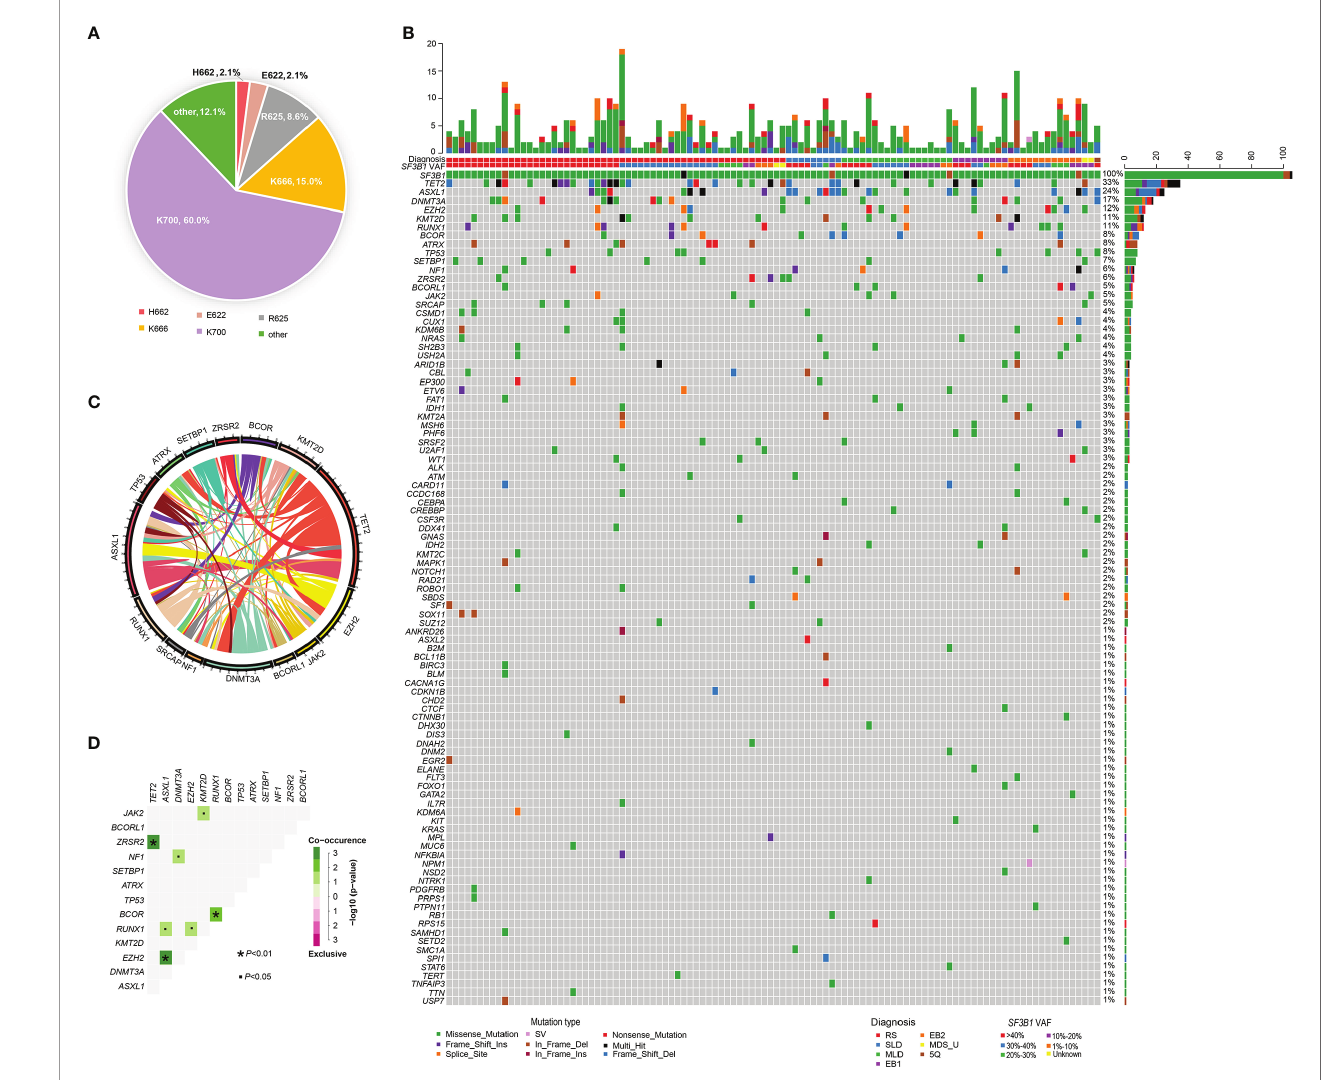
FIGURE 2 | Genomic landscape of MDS patients with SF3B1 mutation. (A) Distribution and proportion of SF3B1 mutation sites in the 140 MDS patients. (B) Heatmap in 106 MDS patients with SF3B1 mutation. Each row represents mutated gene; each column represents a patient; the right side of the graph annotates the frequency and number of the mutated gene; the upper histogram shows the number of gene mutations per patient; different colors below the graph represent different mutation patterns. (C) Circos diagram shows gene association in 106 MDS patients with SF3B1 mutation, according to the relative frequency and pairwise co − occurrence of gene mutations on the basis of the mutated genes detected in ≥ 5 patients. (D) Diagram shows pairwise gene mutation correlations on the basis of the mutated genes detected in ≥ 5 patients, green color represents co-occurrence and pink color represents